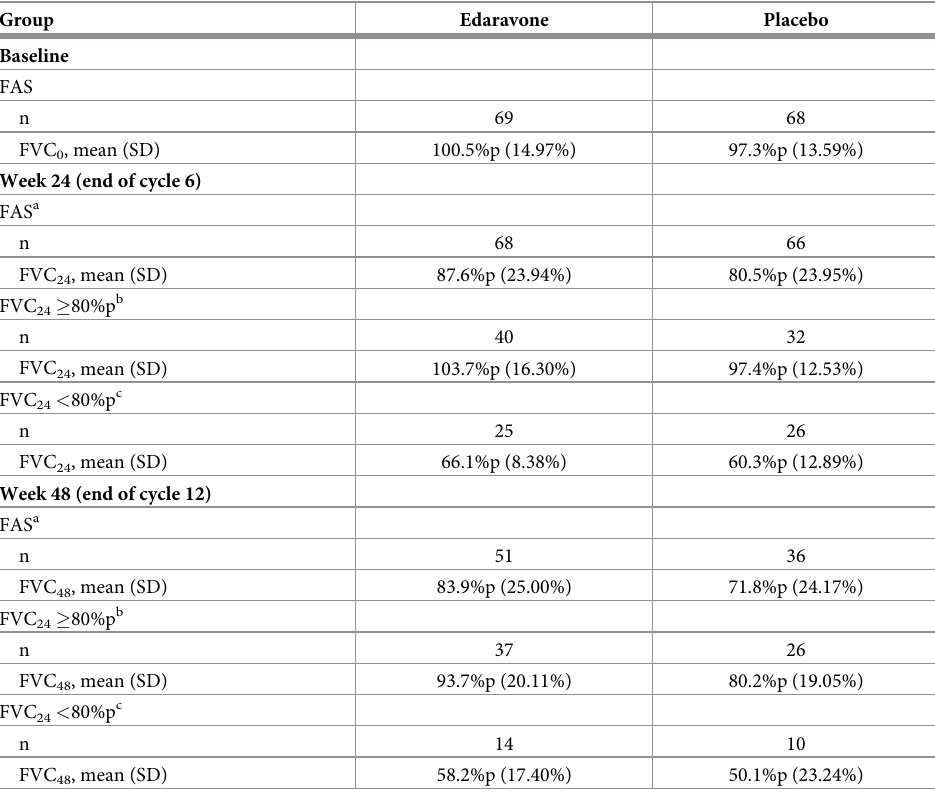
Table 3. FVC values in the analysis